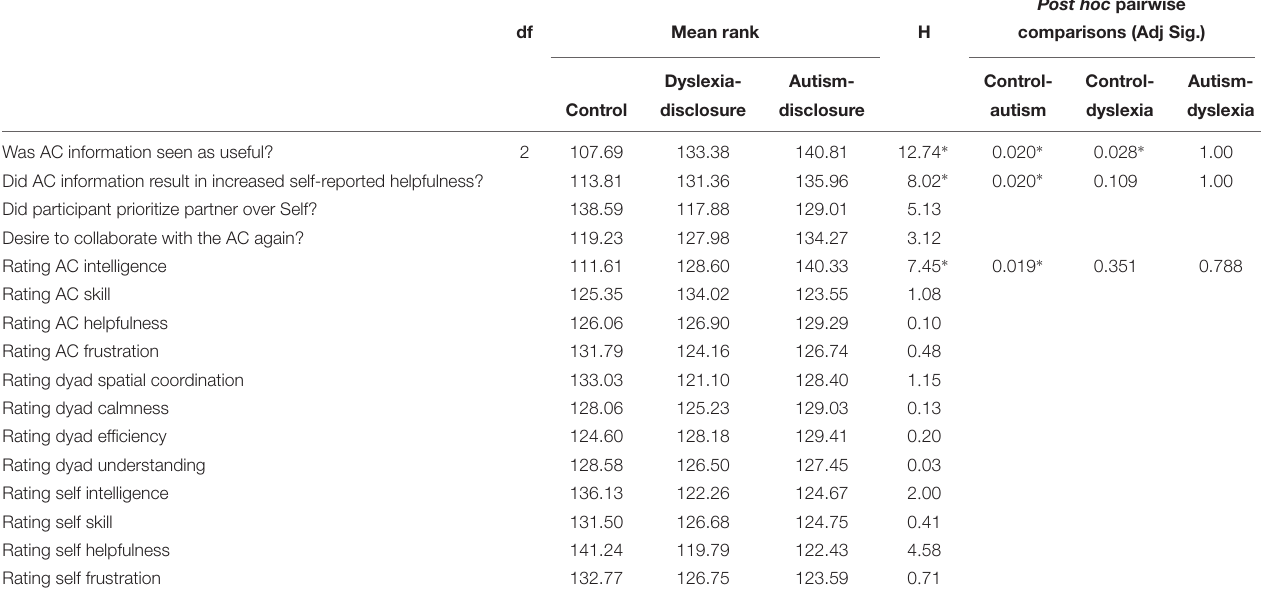
TABLE 3 | Kruskall-Wallis comparison between groups on self-reported and behavioral